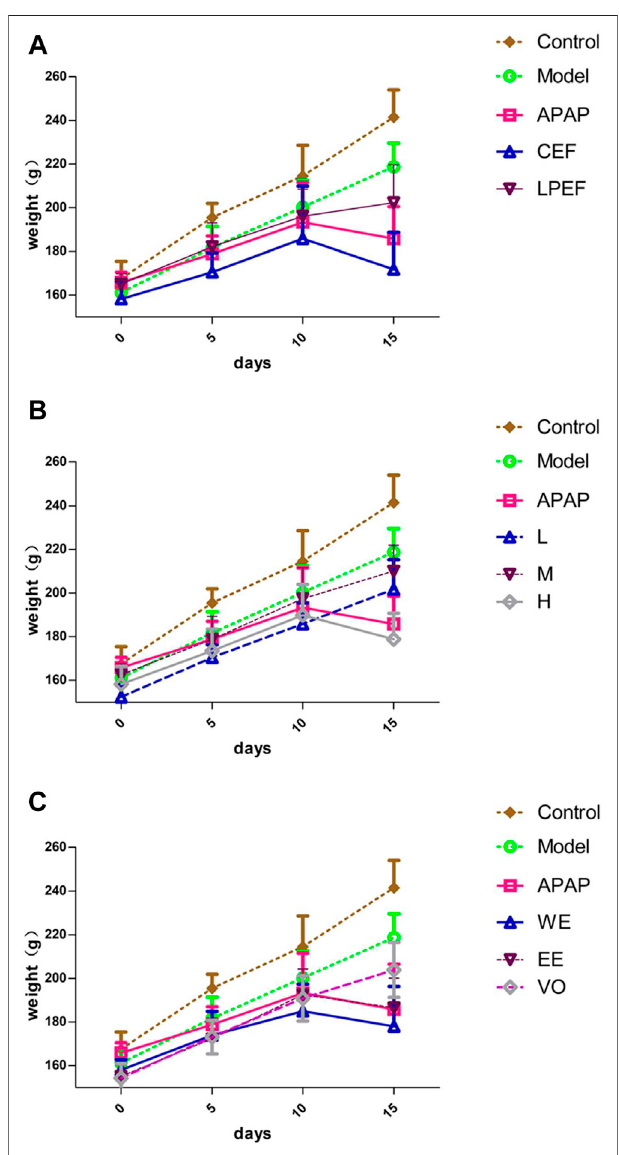
FIGURE 3 | Changing trends of body weight of various groups. (A) WE at high dose in CEF and LPEF. (B) Three doses of WE of CEF. (C) Different extractsathighdoseinLPEF.Valuesaremean ±